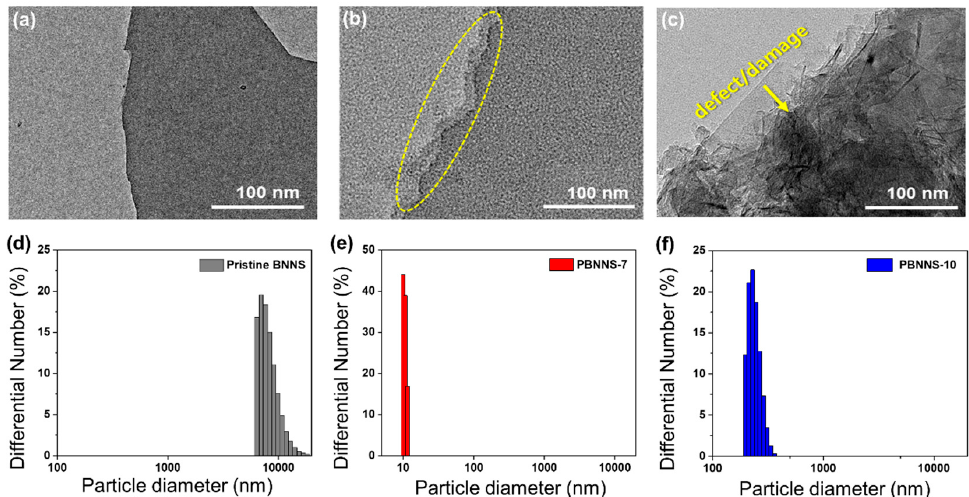
Figure 4. Surface morphology and particle distribution of PBNNS ( a ) TEM images of pristine BNNS, ( b ) PBNNS-7, ( c ) PBNNS-10, particle-size distributions of ( d ) pristine BNNS, ( e ) PBNNS-7, and ( f )